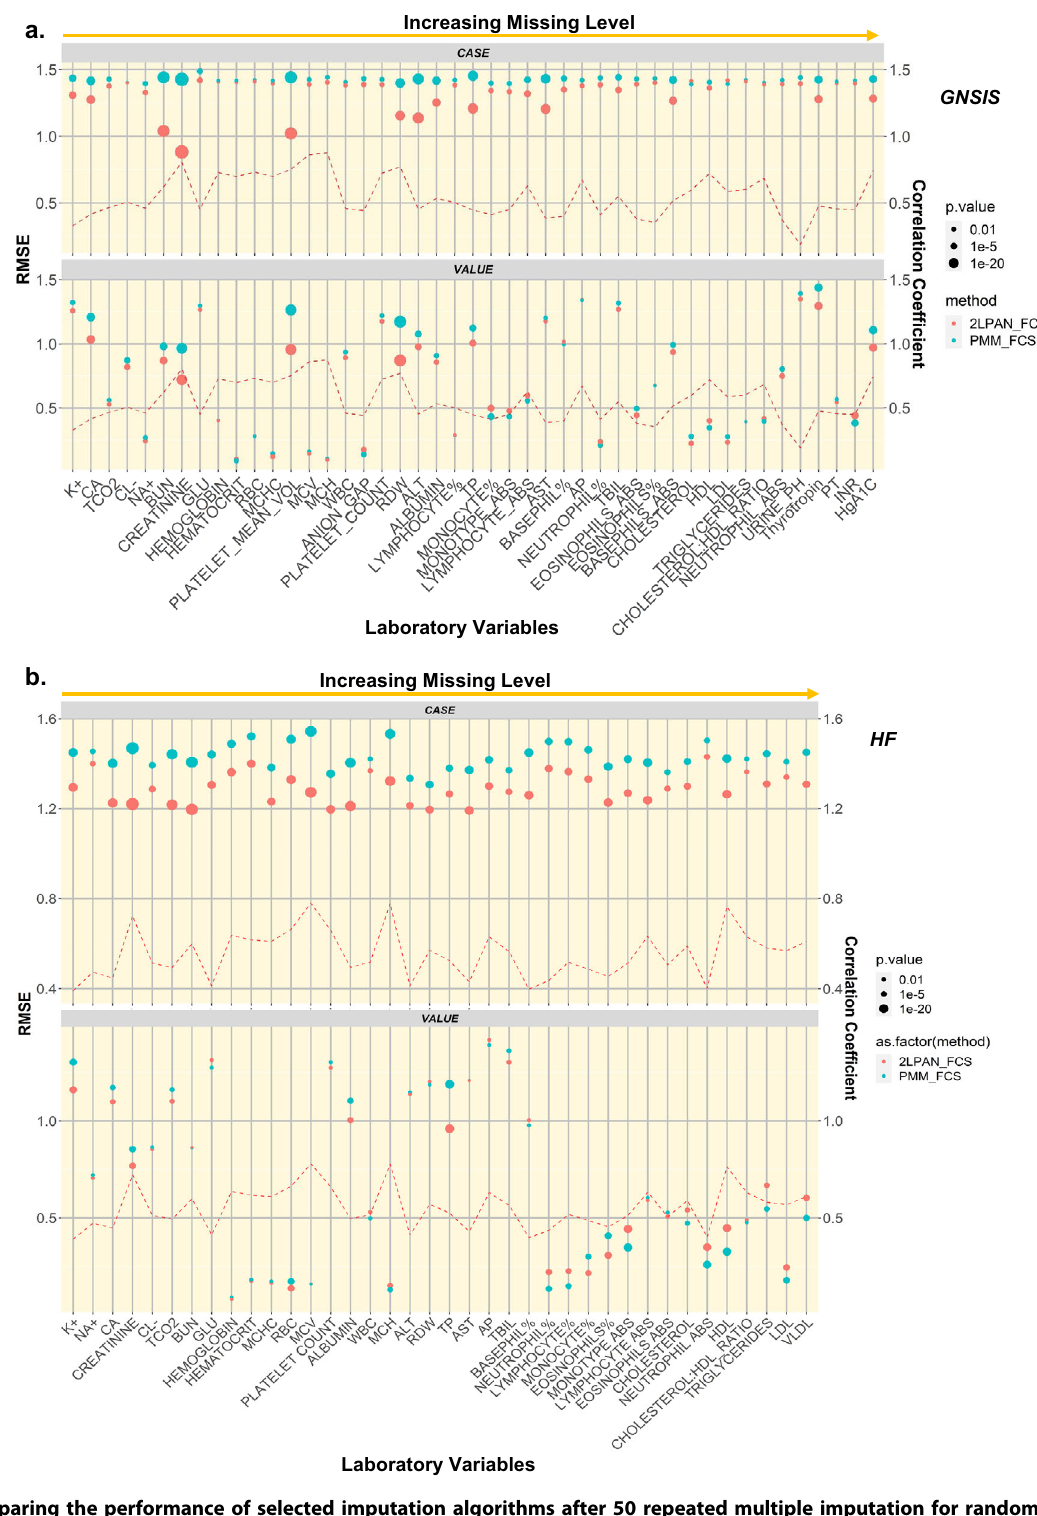
Fig. 6 Comparing the performance of selected imputation algorithms after 50 repeated multiple imputation for random holdout cases (HC) or values (HV) using nRMSE in GNSIS and HF datasets. Levene ’ s test showed an equal variance of the nRMSE from two compared imputation algorithms, e.g. 2LPAN-FCS and PMM-FCS. Shapiro-Wilk test showed the normality of the difference for each comparison. An unpaired t -test was conducted to determine the mean difference of nRMSE between two compared imputation algorithms. Only the raw p -value < 0.05/45 (~0.0011) for GNSIS ( a ) or < 0.05/38 (~0.0013) for HF ( b ) was considered as statistical signi fi cance, which survived the Bonferroni correction for multiple testing. The curve for Pearson ’ s correlation coef fi cient of observed values between before and after index date per variable was overlaid to the corresponding dot plot for normalized